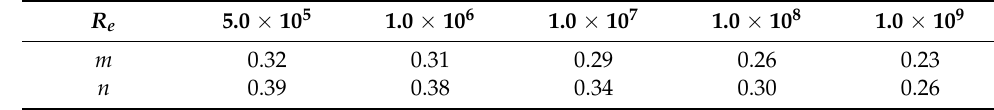
Table 3. Suggested scaling exponents for five main Reynolds numbers.